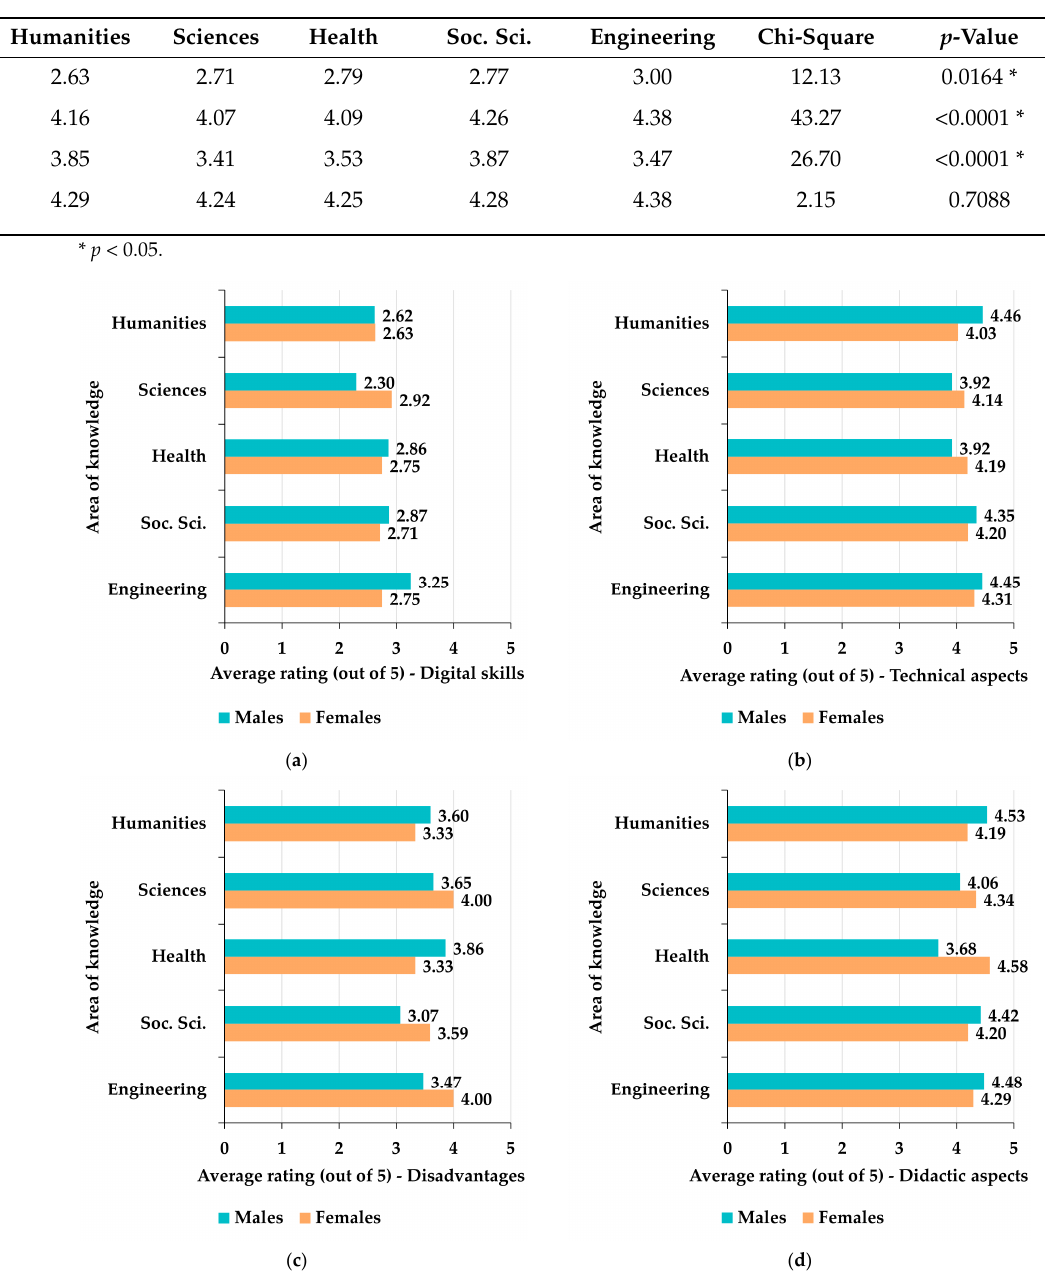
Table 5. Descriptive statistics of the responses to the different families of questions and statistics of the Kruskal–Wallis test for comparison of mean values.